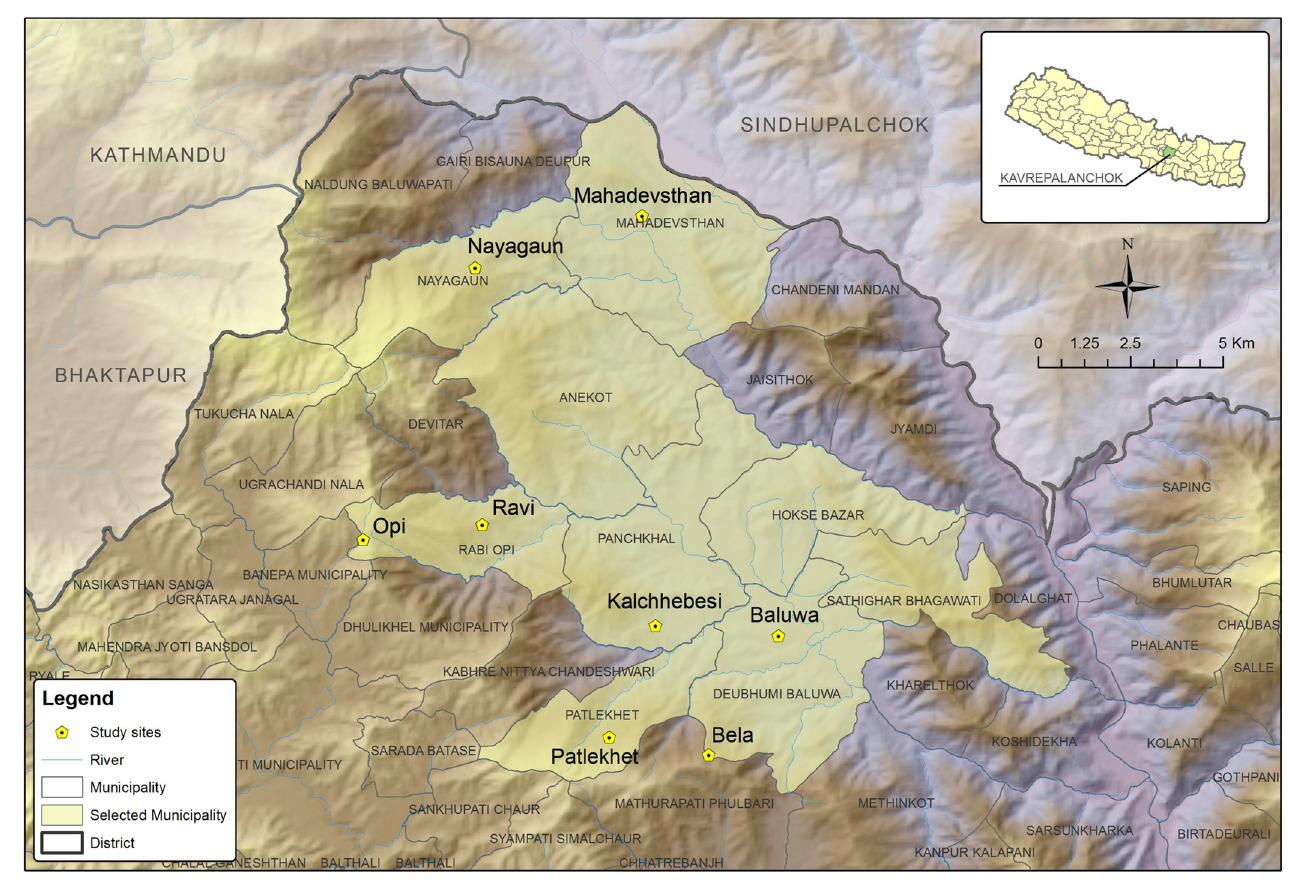
Fig 3. Study sites at Kavre district of Nepal. (Source: ICIMOD).